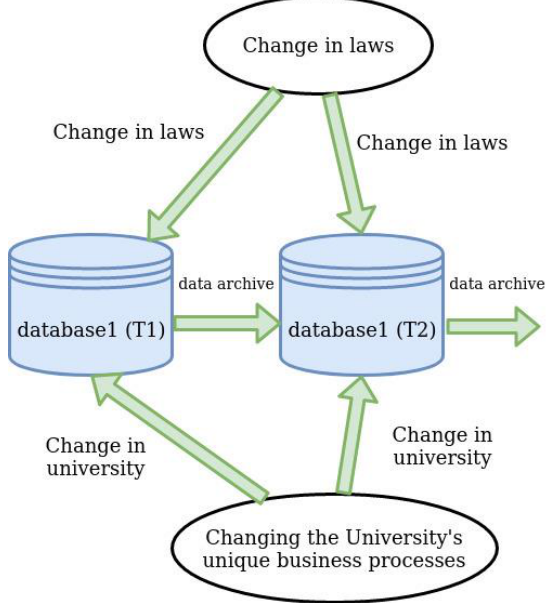
Fig. 1. The database change scheme of a digital university